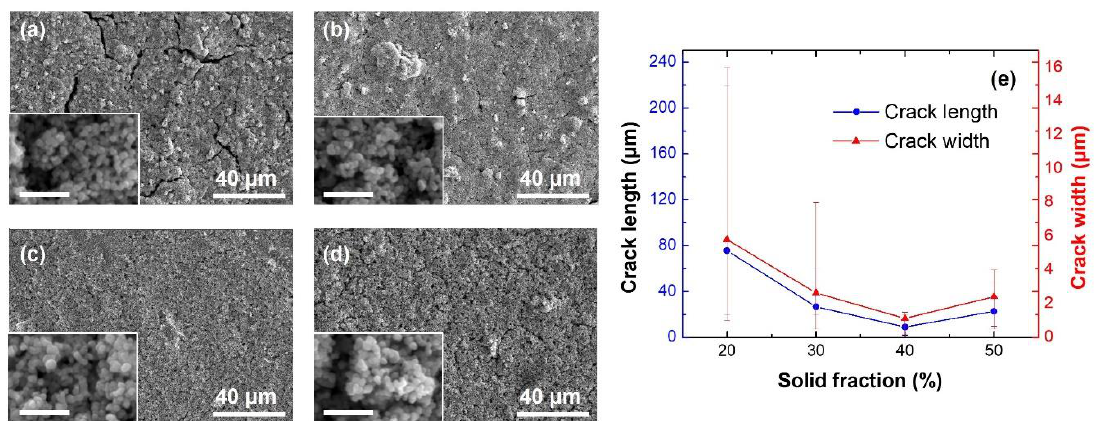
Figure 2. Interconnects prepared by using nano-copper inks with solid fractions of ( a ) 20%, ( b ) 30%, ( c ) 40% and ( d ) 50%, respectively. The insets show microstructures at large magnifications. The scale bars in the insets stand for 500 nm. ( e ) The length and width of cracks in the interconnects varying with the solid fractions of the inks. Water was used as the ink solvent.